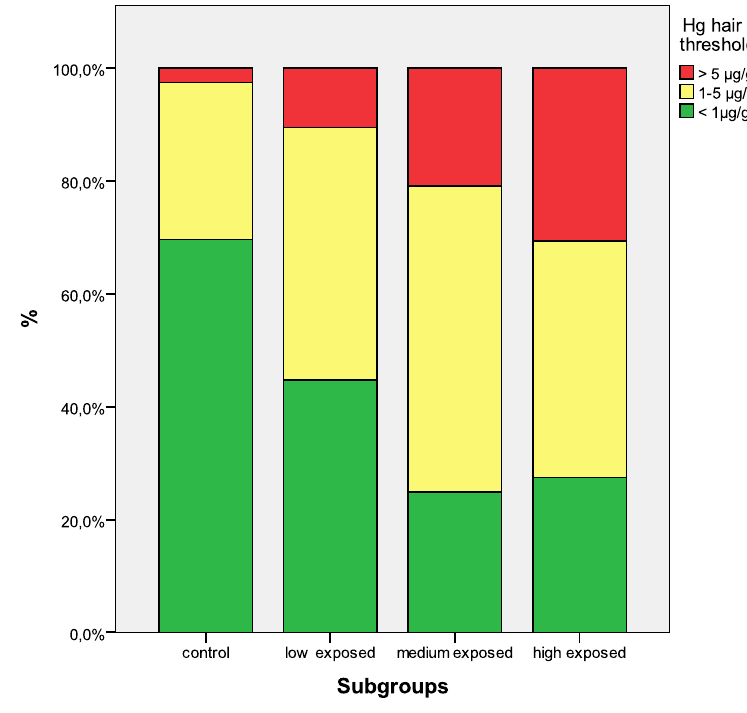
Figure 8. Mercury in hair—stacked bar chart for threshold